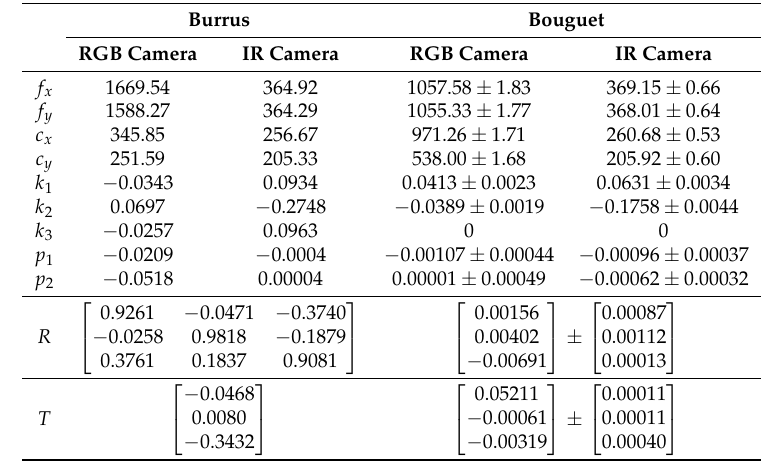
Table 5. Calibration results for Microsoft Kinect V2.